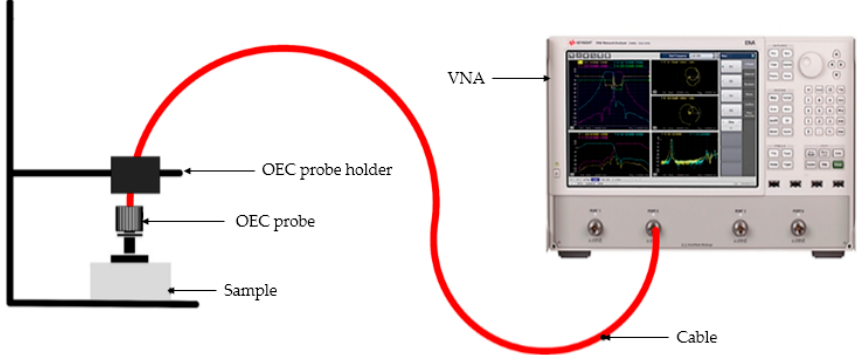
Figure 2. Complex permittivity measurement set-up. OEC, open ended coaxial.